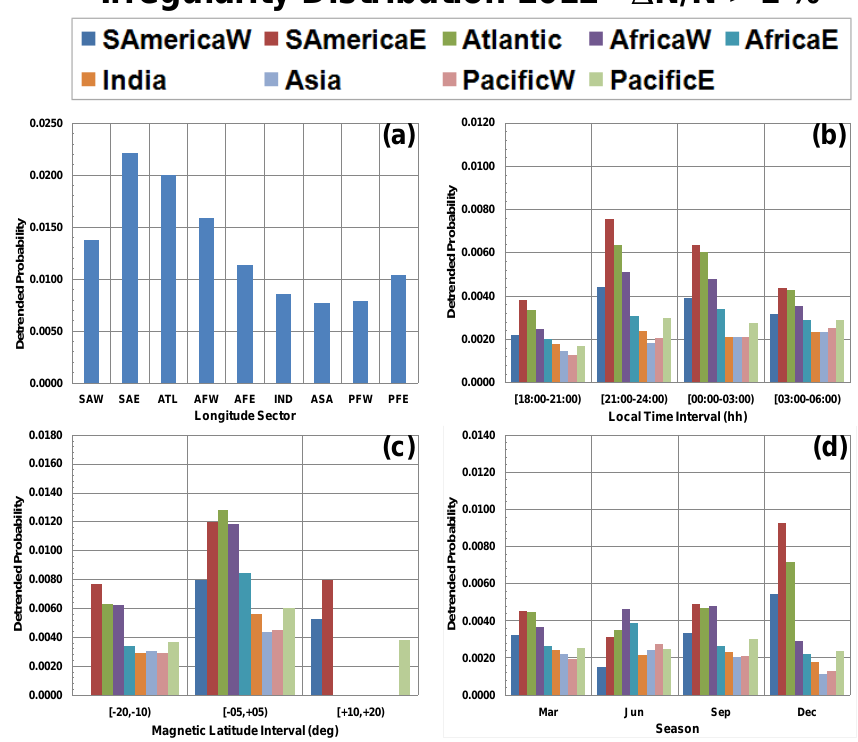
Figure 11. Detrended probability distributions of N i / N i > 1 % recorded during 2012 as functions of: (a) longitude sectors; (b) local time intervals; (c) magnetic latitude intervals; and (d) seasons. The vertical axes coincide with those of the central panels of Figures 6, 8, 9, and 10, respectively.